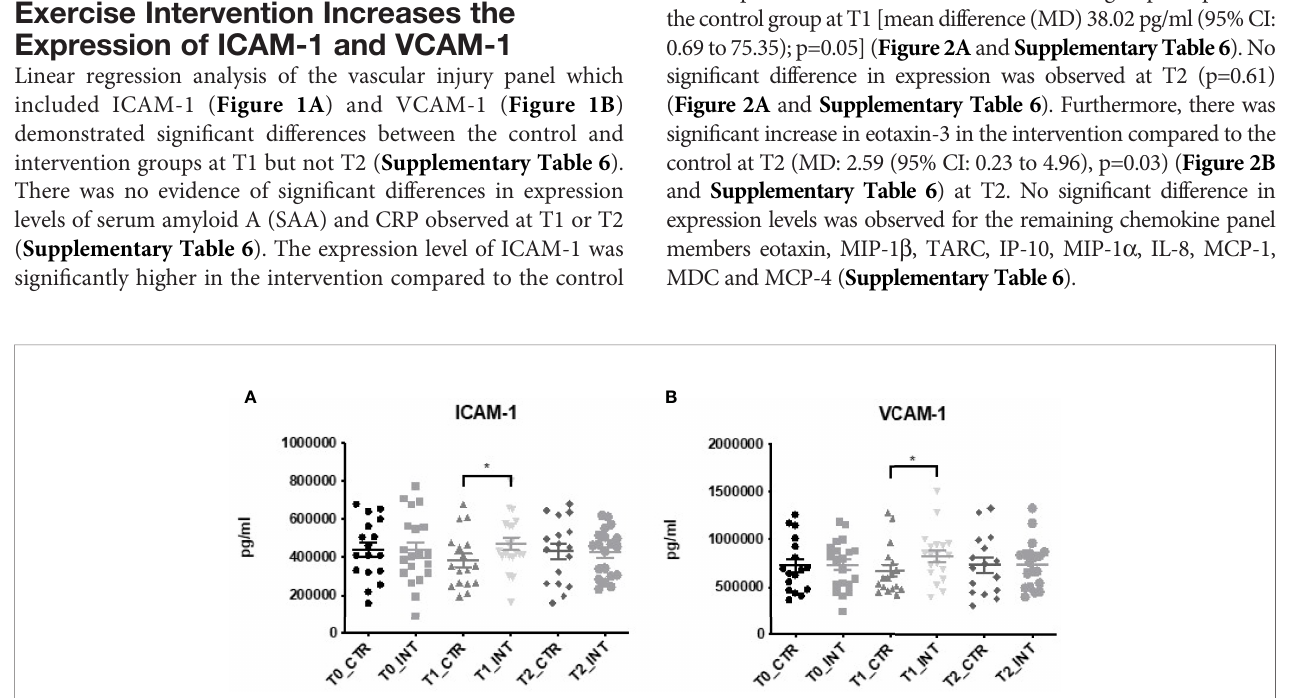
FIGURE 1 | Multiplex ELISA analysis of Vascular injury panel. Data at immediately post 12-week intervention (Time 1; T1) and at 3-month follow-up (Time 2; T2) was analyzed using linear regression models, adjusting for baseline values (T0). A signi fi cant increase in serum (A) ICAM-1 and (B) VCAM-1 expression was observed at T1 (*p ≤ 0.05).